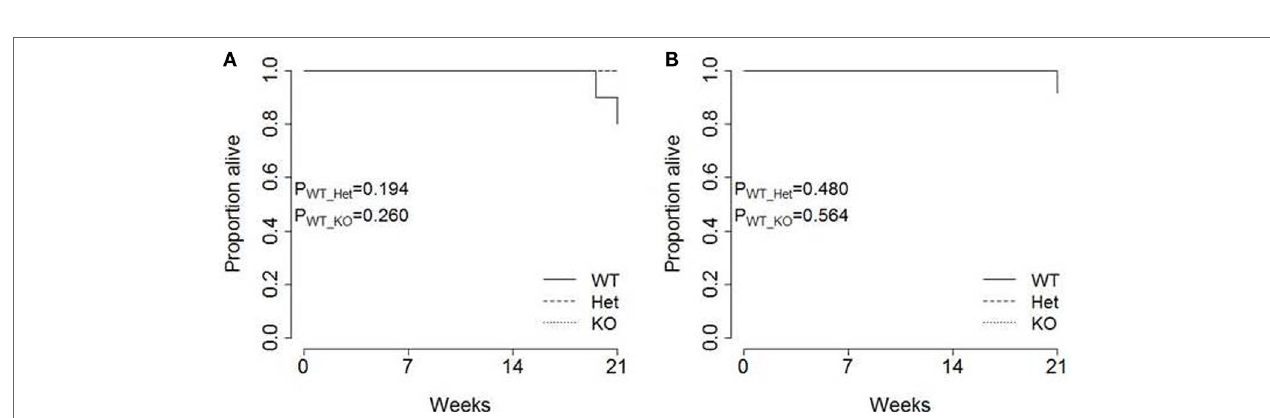
FigUre 5 | Tumor-induced mortality is unaffected in miR-342 knockout mice . TAg + , miR-342 + /0 TAg + , and miR-342 0/0 TAg + mice were followed until 21 weeks of age. Kaplan–Meier analysis of survival in (a) female ( n = 10, 8, 6) and (B) male ( n = 13, 6, 4) mice.